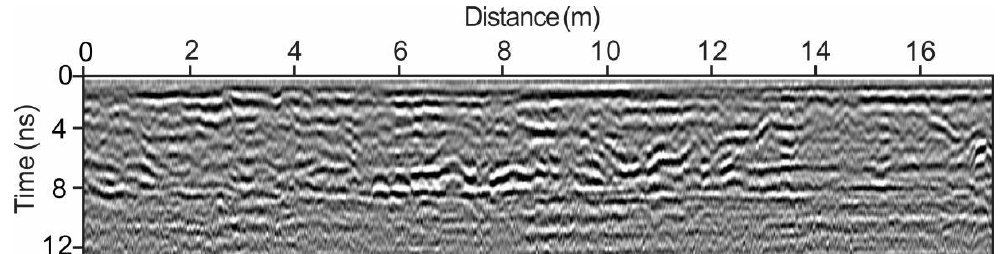
Figure 4. Inline profile of the 3D GPR data after time zero correction and preprocessing.